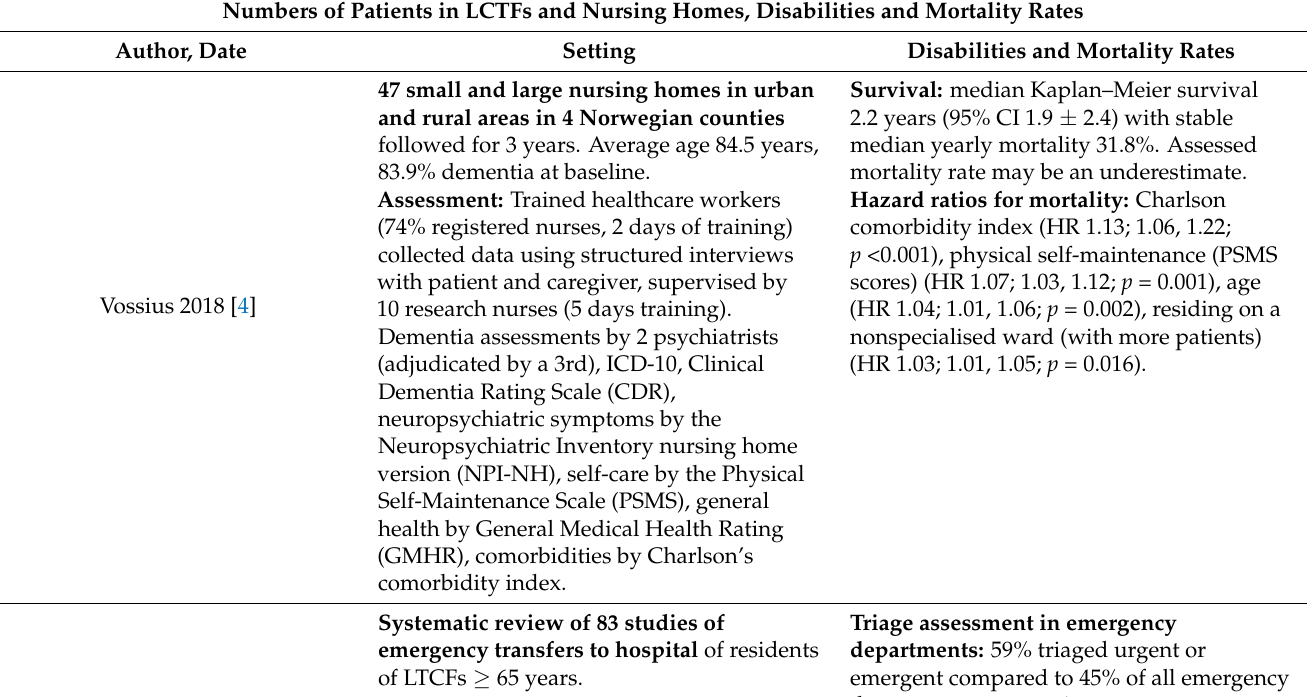
Table 3. Numbers of patients in nursing homes and LCTFs, disabilities, mortality rates and respiratory infections. Numbers of Patients in LCTFs and Nursing Homes, Disabilities and Mortality